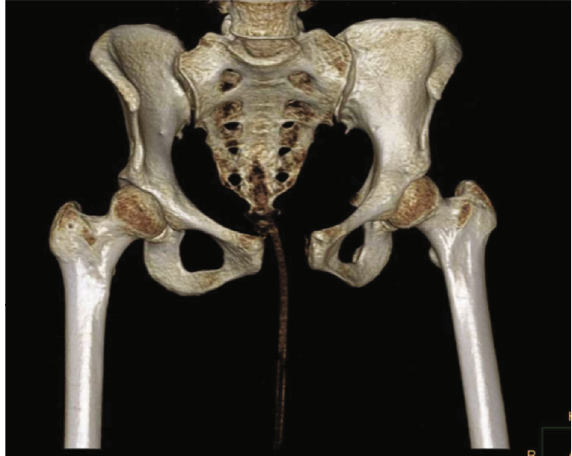
Figure 2: 3D CT reconstruction of the pelvis redemonstrating separation of the pubic symphysis.